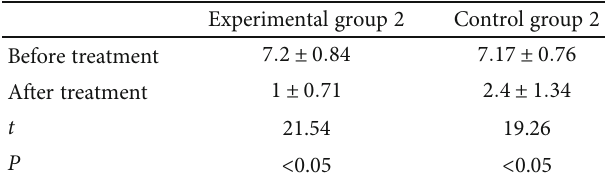
Table 3: Pain score.